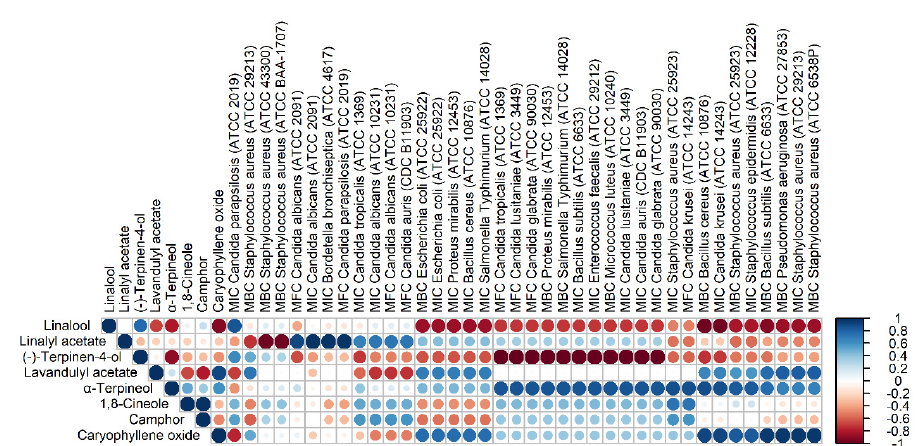
Figure 3. Corrplot presenting Pearson correlation coefficients for percentage content of eight primary constituents of studied essential oils and MIC/MBC/MFC doses determined for tested microorganisms. To gain further insight into the correlations between the percentage of dominant components and the MIC, MBC, and MFC values, scatter plots were made for individual correlations and visually assessed, and then those representing the most likely correla ‐ tions were selected (Figure S1). The selected correlations include those between the per ‐ centage of linalool and terpinen ‐ 4 ‐ ol and the MBC values for B. cereus (ATCC 10876), B. subtilis (ATCC 6633) and the MIC values for C. krusei (ATCC 14243). The relationships between the contents of these flocculants in oils and the biological activity values of the oils against these strains are shown in Figure 4.